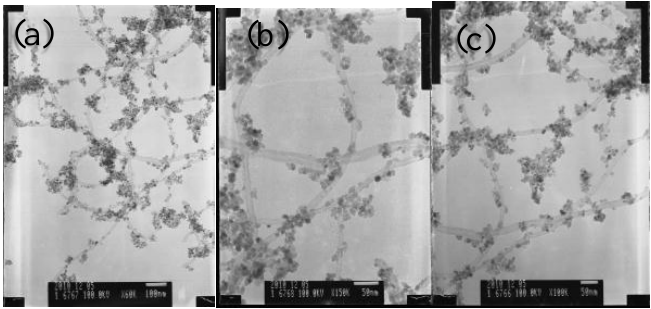
Figure 3. Transmission electron micrographs (TEM) of SnO 2 -CNTs nanocomposites. ( a ) low magnification; ( b , c ) high magnification The ultraviolet-visible diffuse reflection (UV-Vis DRS) spectrum of SnO 2 and SnO 2 -CNTs were measured using a UV-Vis spectrophotometer with an integrating sphere (Hitachi U-3900), as shown in Figure 4. The absorption threshold of pure SnO 2 is 372 nm. It presents a strong absorption band only in the UV region. However, SnO 2 -CNTs sample extended the absorption range to the visible region, and the absorption edge red-shifted from 372 nm to 425 nm compared to pure SnO 2 , suggesting that SnO 2 -CNTs has the potential to be an efficient visible-light-activated photocatalyst.